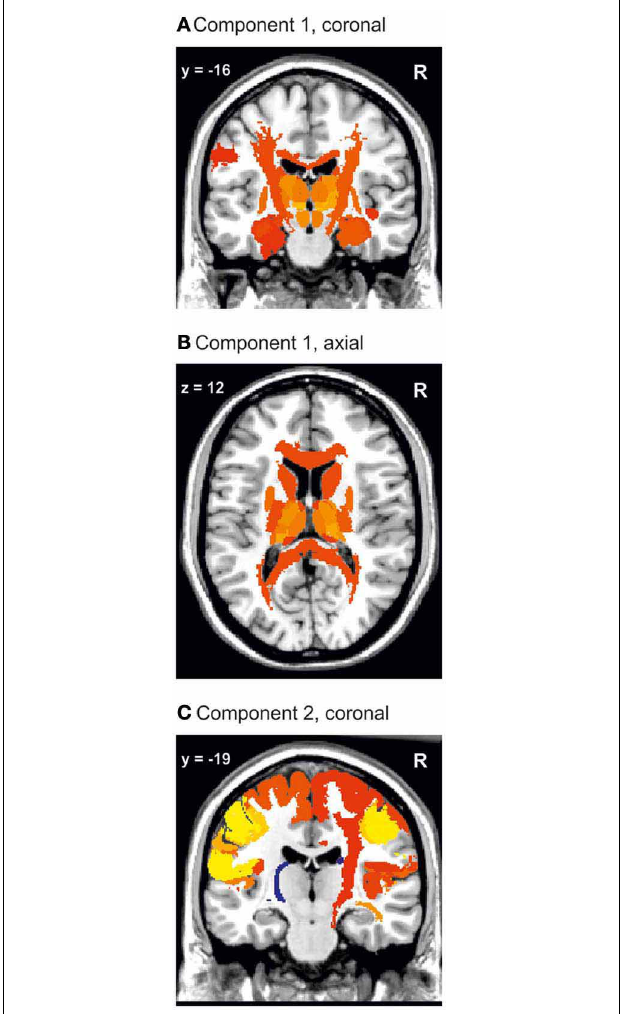
FIGURE 3 | Visualization of the first and second PCA component. Component 1 (A,B) includes the whole corpus callosum and the thalamic nuclei. In (C) it can be seen that the major constituents of component 2 are the sensorimotor cortices and the right corticospinal tract. Color coding: red to yellow, coefficient of the eigenvalue > 0.1. Dark blue to light blue, coefficient of the eigenvalue < − 0.1.